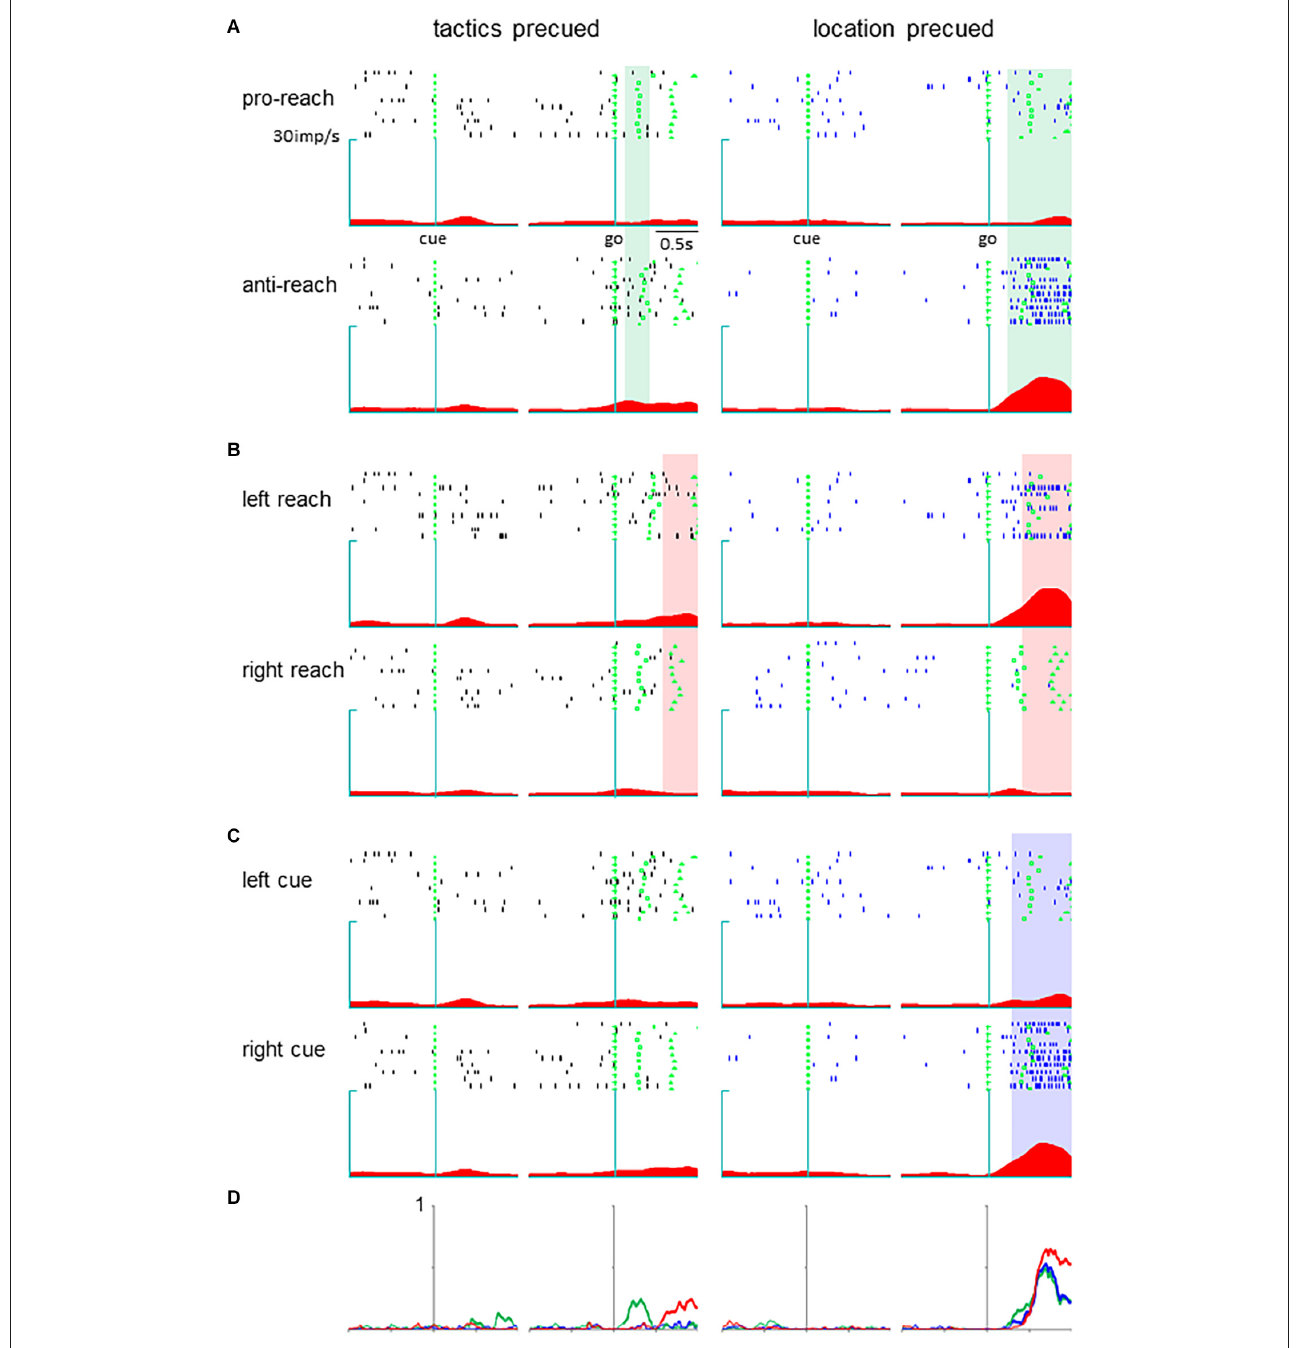
FIGURE3 A pmPFC neuron encoding different information during the response period of the two tasks. The legends are the same as in Figure 2 .